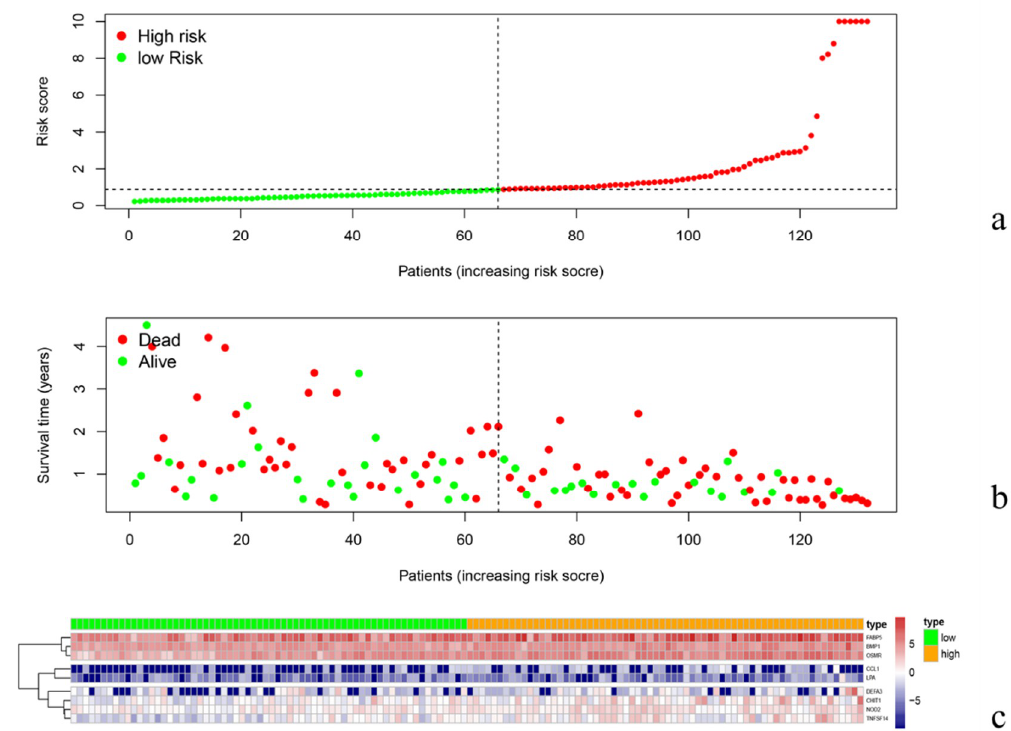
Figure 4. The survival was prolonged in low-risk patients compared to the high-risk group ( a , b ), and the changes in gene expression are shown by increased the risk score ( c ).